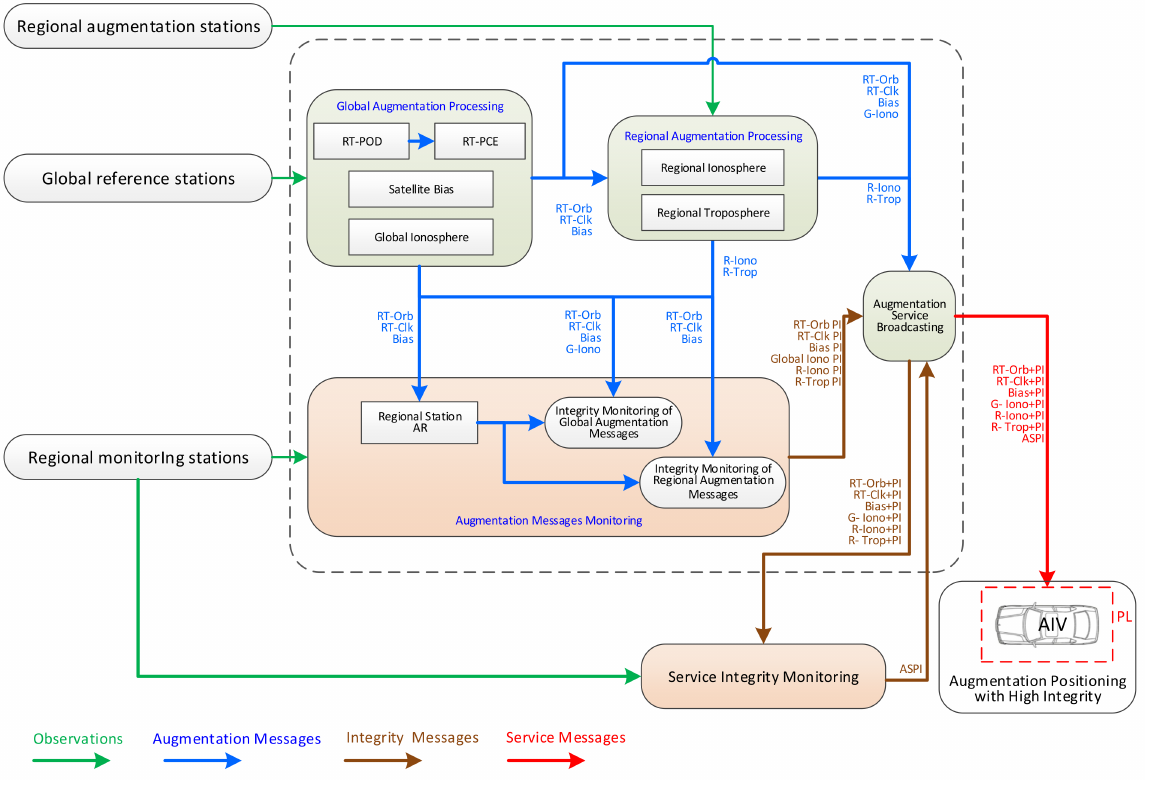
Figure 5. GNSS high-precision augmentation solution for AIV. POD: precise orbit determination, PCE: precise clock